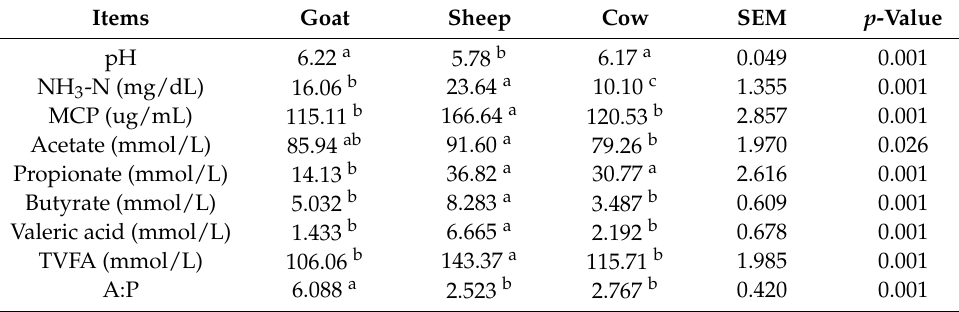
Table 4. Rumen fluid parameters of the goat, sheep, and cow. Items Goat Sheep